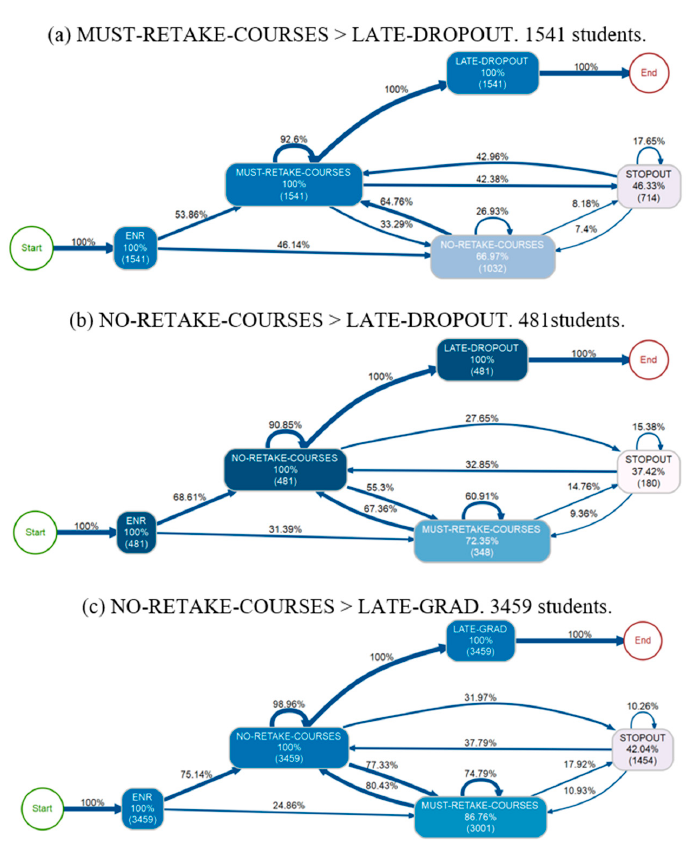
Figure 5. Educational trajectories in high-failure rate courses, according to the RETAKE-STOPOUT model. ( a ) Shows only students who had MUST-RETAKE-COURSES > LATE-DROPOUT transitions. ( b ) Shows only students who had NO-RETAKE-COURSES > LATE-DROPOUT transitions. ( c ) Shows only students who had NO-RETAKE-COURSES > LATE-GRAD transitions. The darker color of the nodes represents a higher percentage of students who went through a state. The thickness of the arrows represents the percentage of students who had transitions between both states. All values are percentages in relation to the total number of students included in each